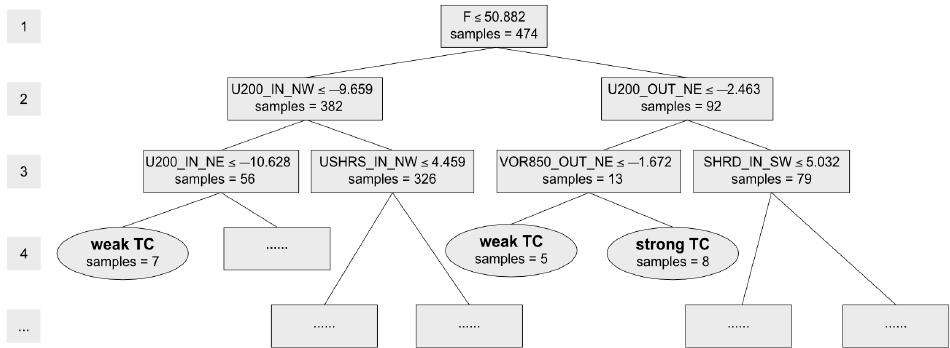
Figure A1. Classification and regression tree (CART) constructed by features at genesis in this study. Rectangles are parent nodes, ellipses are leaf nodes. Inequality in rectangles suggests judging condition of each leaf node; the left branch leads to positive conditions and right branch leads to negative, and the number of cases split on each branch is shown by “samples”. Sequence numbers in the left column refer to depth of each dividing